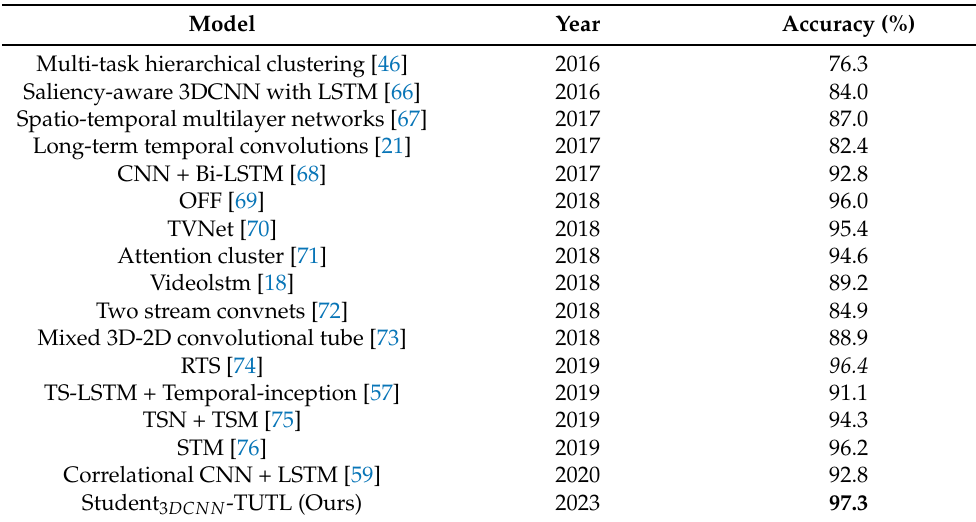
Table 10. Quantitative comparative analysis of our proposed method with the state-of-the-art action recognition methods on UCF101